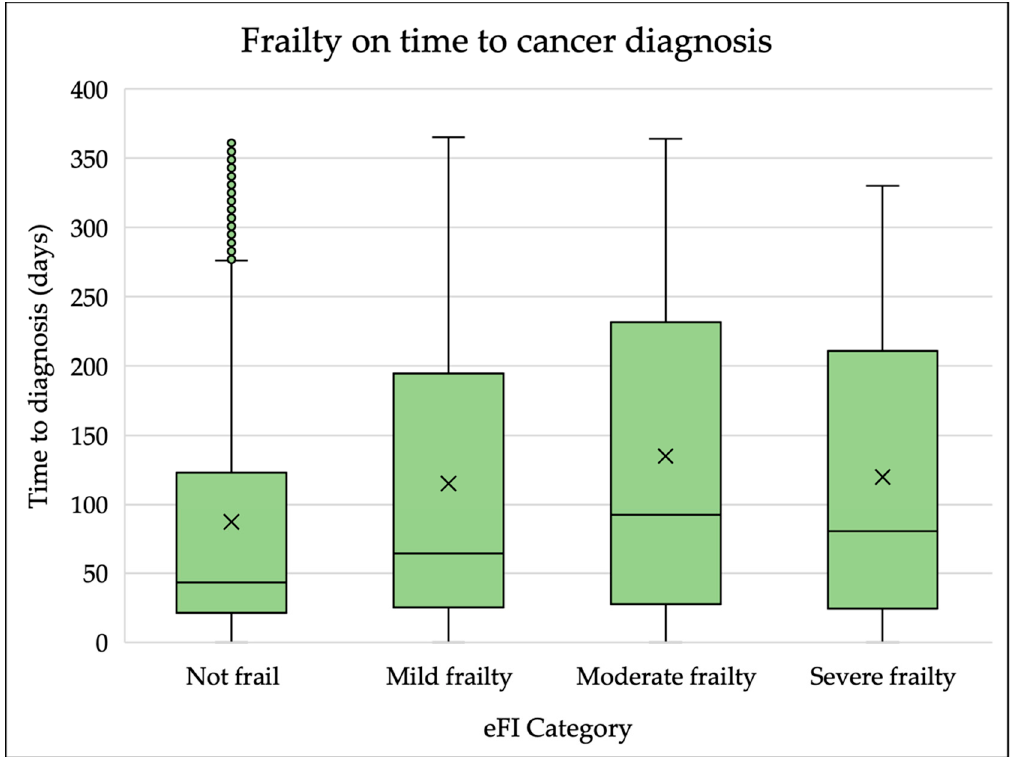
Figure 2. Box plots of time to cancer diagnosis by level of frailty. X represents the mean value Quantile regression compared the time to diagnosis by frailty score and age. These results were then adjusted for potential confounders including sex, ethnicity, cancer type and IMD. The results are shown in Table 2 (below). Mild and moderate frailty were sig- nificantly associated with a longer time to diagnosis at the median, 75th and 90th centile in both the unadjusted and adjusted results. Mild frailty added 21 days (95% CI 15–27) and moderate frailty added 49 days (95% CI 23–75) to the median time to diagnosis com- pared to not frail patients. Severe frailty added 44 days (95% CI − 13–101) but this was not statistically significant. After adjustment for potential confounders, mild frailty added 7 days (95% CI 2–11) and moderate frailty added 23 days (95% CI 4–42) to the median time to diagnosis compared to not frail patients. After adjustment, severe frailty added 11 days (95% CI − 27–48) to the median time to diagnosis however this was not statistically signif- icant, likely as a result of small numbers in this group ( n = 52). Increasing age was not associated with time to diagnosis after adjustment for potential confounding variables. Testing for two-way interactions identified a significant interaction between frailty and age ( p = 0.010) and frailty and cancer type ( p = 0.000). Table 3 (below) shows the me- dian time to diagnosis by level of frailty, stratified by age group. Moderate frailty had the greatest effect on time to diagnosis for the 18–64 and 65–74 years age groups, delaying median time to diagnosis by 171 days (95% CI 75–266) and 97 days (95% CI 42–152), re- spectively compared with the not frail group.